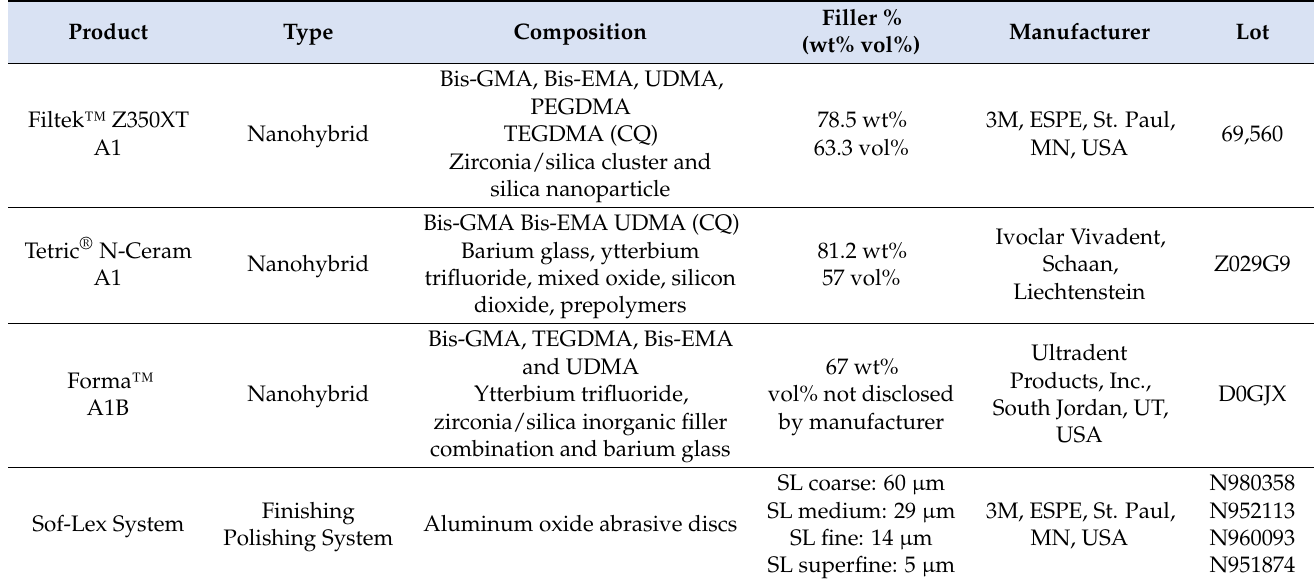
Table 1. Technical profile of products